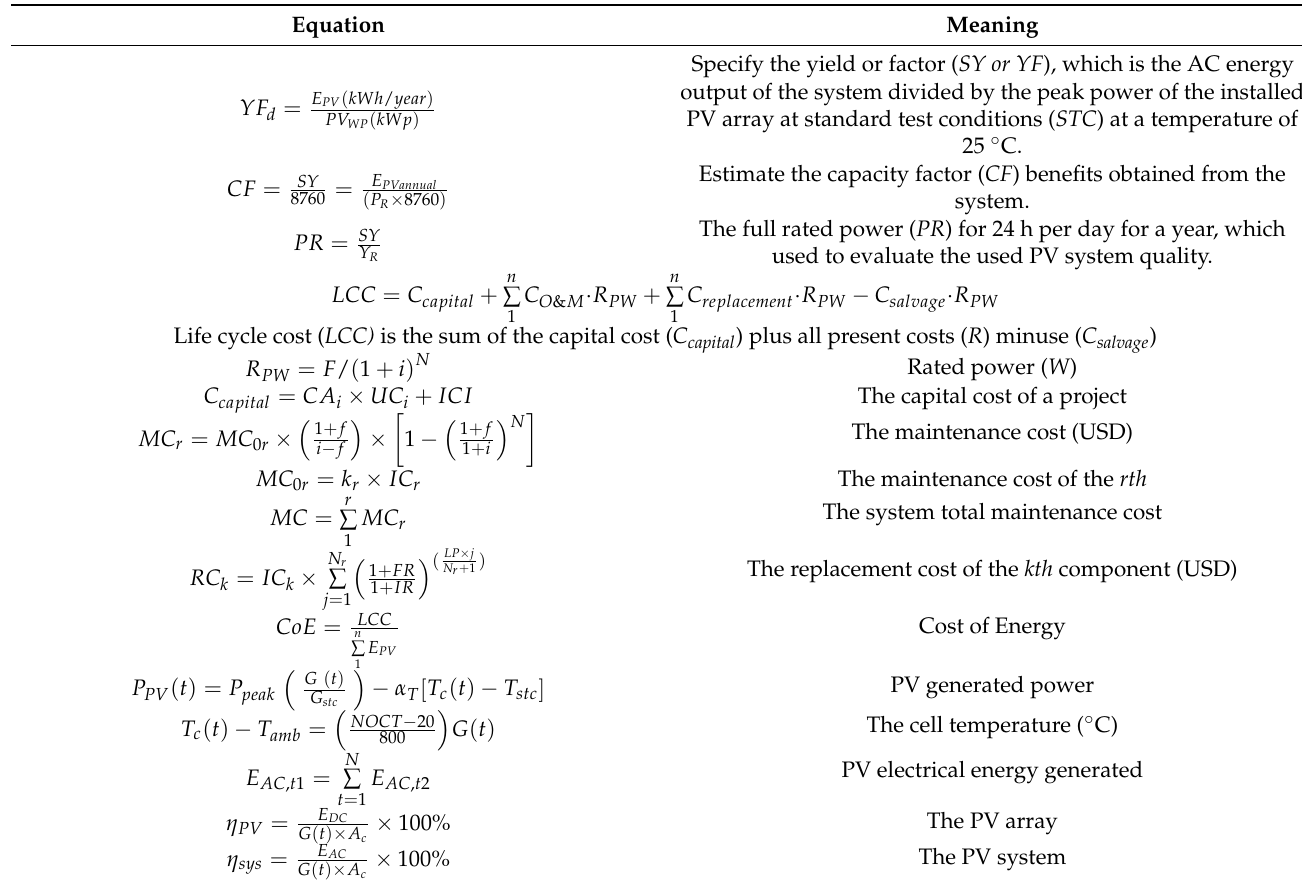
Table 4. The equations to compute the PV-power production. Equation Meaning Specify the yield or factor ( SY or YF ), which is the AC energy output of the system divided by the peak power of the installed PV array at standard test conditions ( STC ) at a temperature of 25 ◦ C. Estimate the capacity factor ( CF ) benefits obtained from the system. The full rated power ( PR ) for 24 h per day for a year, which used to evaluate the used PV system